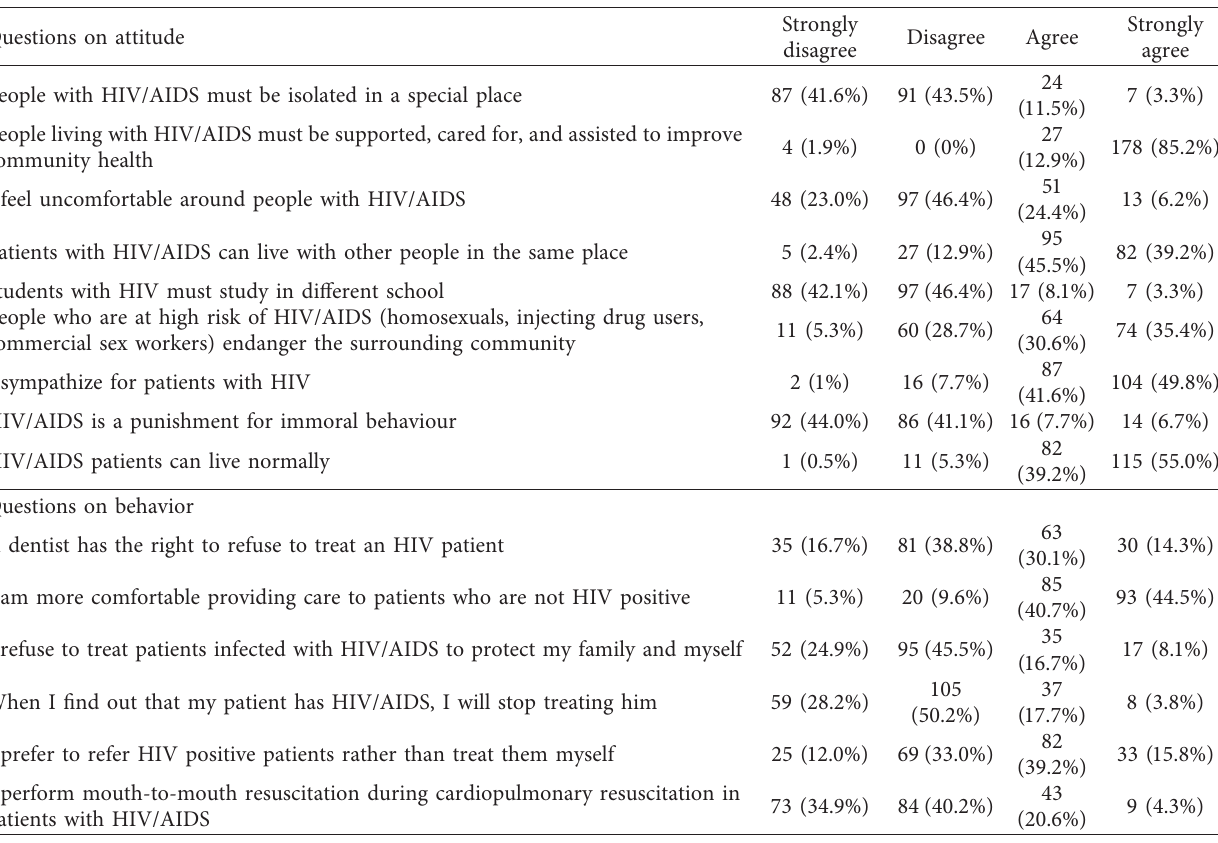
Table 4: Response of dentists to attitude and behavior statements about HIV/AIDS.